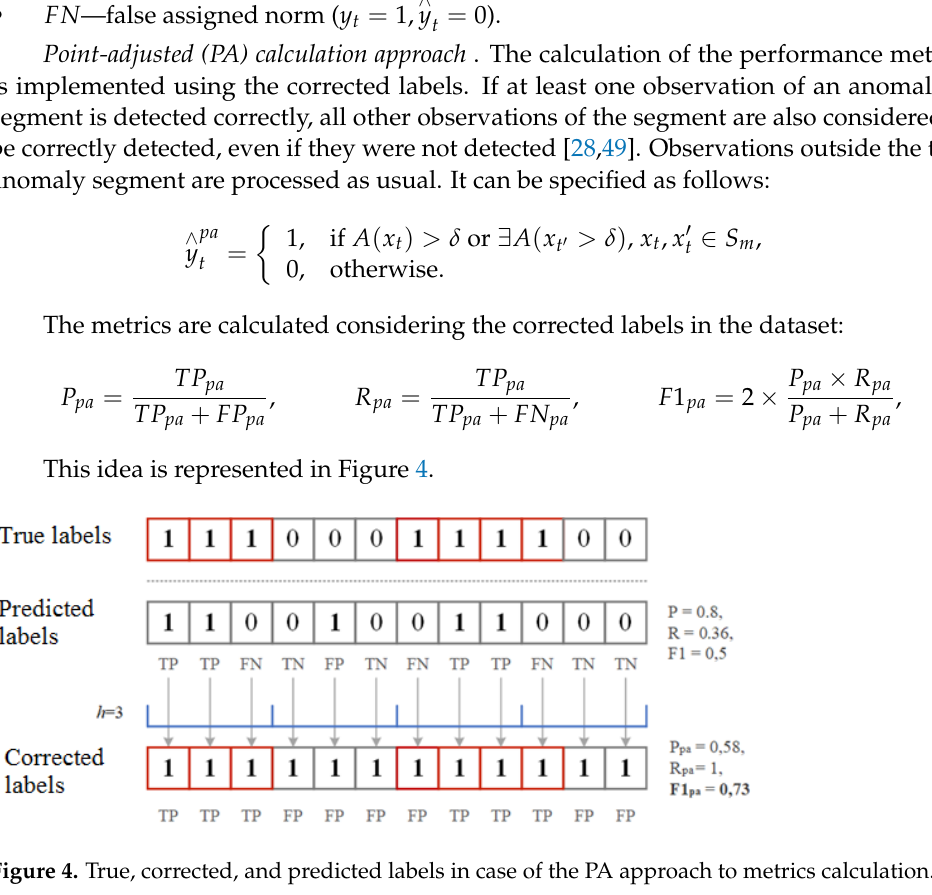
Figure 4. True, corrected, and predicted labels in case of the PA approach to metrics